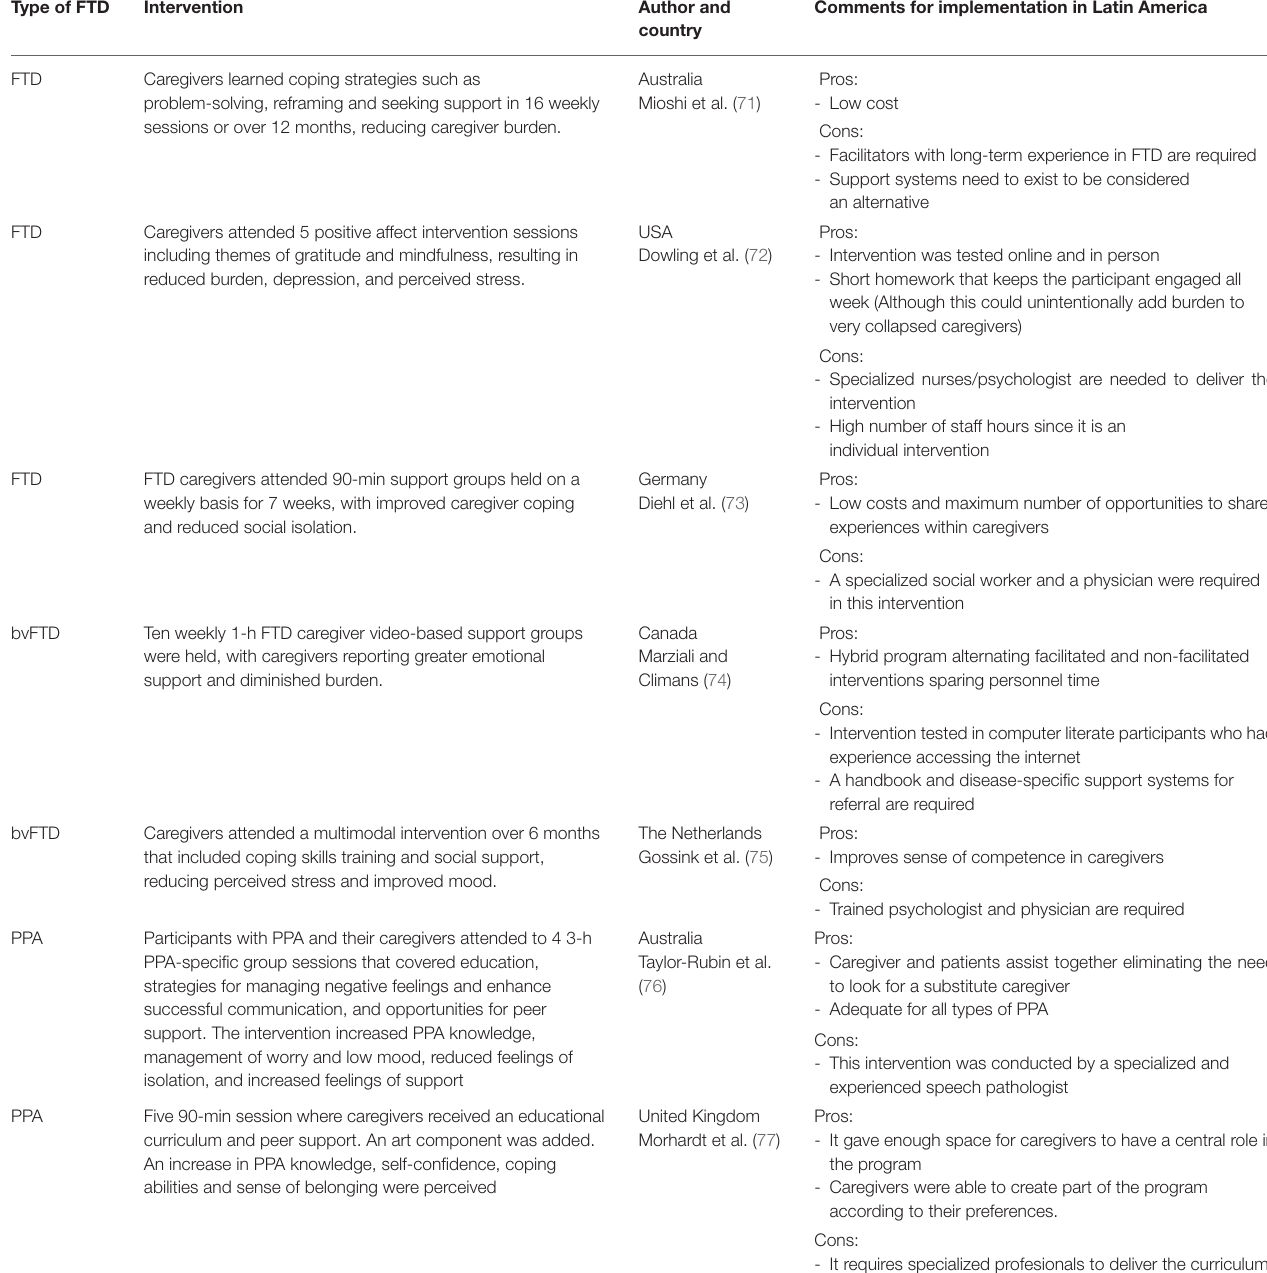
TABLE 1 | Interventions for caregivers and implementation observations in Latin